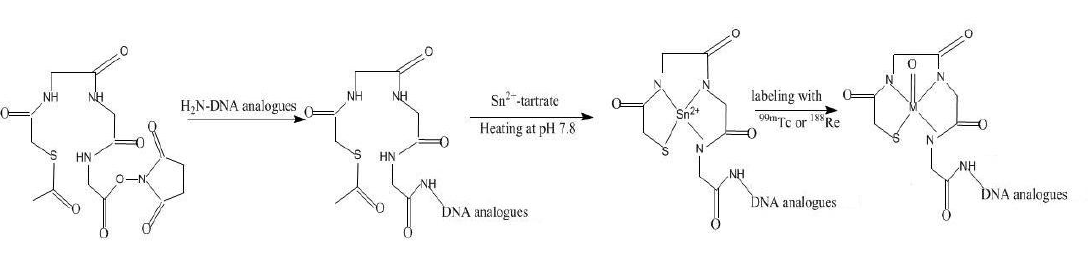
Figure 2. Conjugation of the NHS-MAG